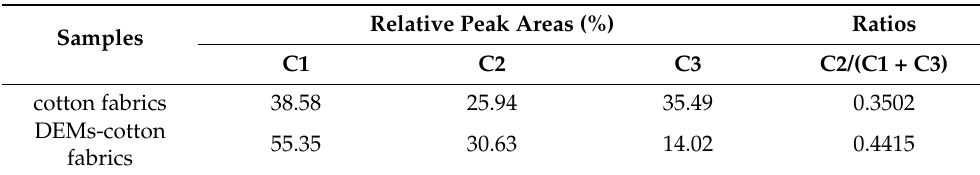
Table 1. C1s deconvolution XPS data of cotton fabrics and DEMs-cotton fabrics of the relative peak areas of C groups.